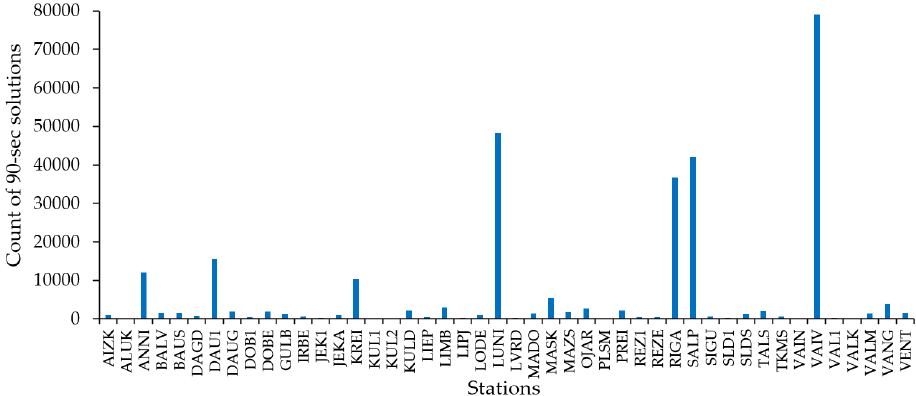
Figure 13. Distribution of total count of sequential 90-s faulty solutions.